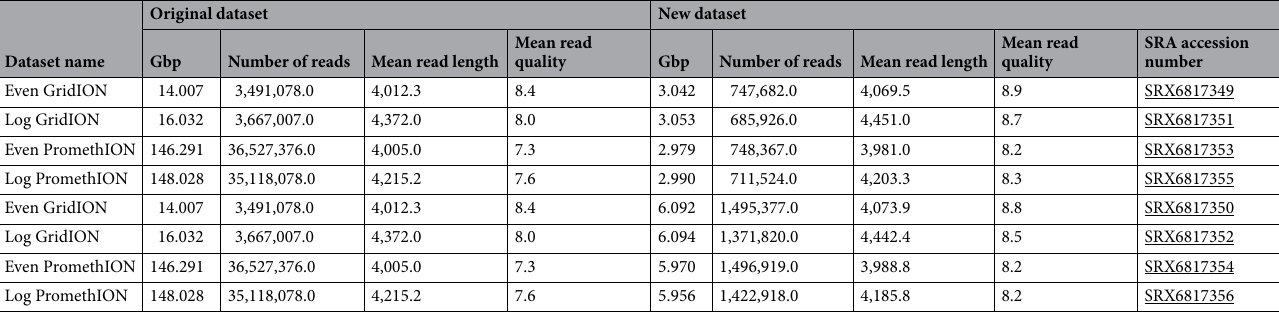
Table 2. Sequencing statistics for the original and the subsampled